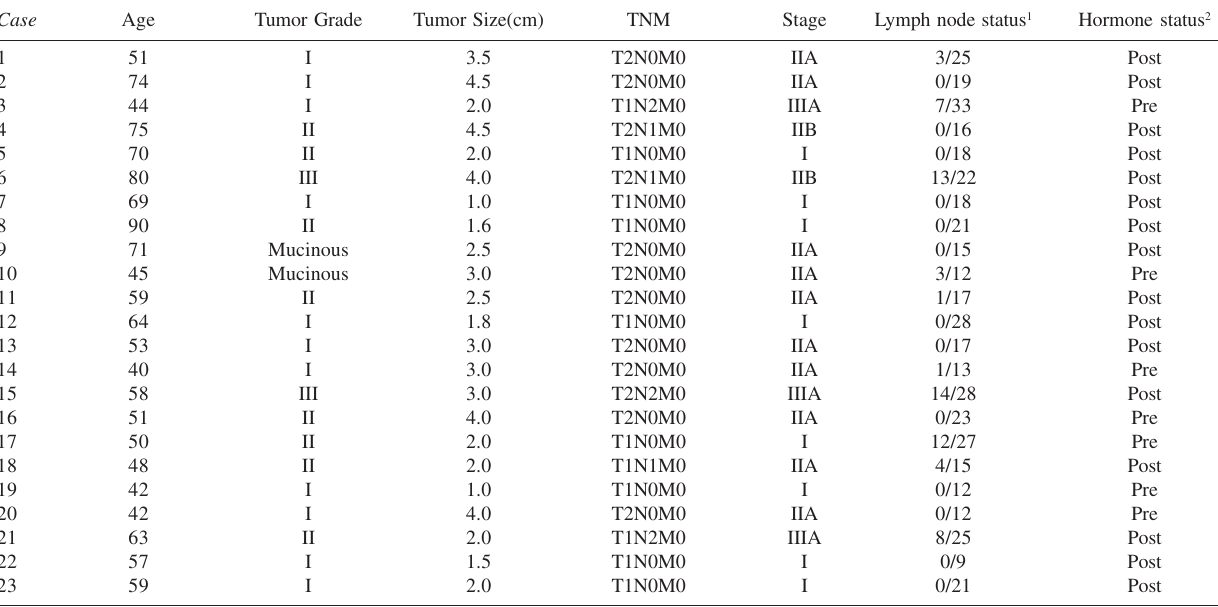
Table 1 - Clinical and pathological characteristics of patients with breast cancer